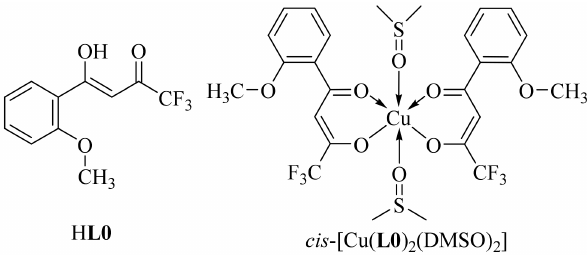
Figure 3. Structures of ligand H L0 and complex cis -[Cu( L0 ) 2 (DMSO) 2 ] [40]. Of 31 cancer incidences in women, the fourth most frequent type is cervical carci- noma [46]. Hence, the human cervical epithelioid carcinoma cell line was chosen as a tumorigenic. The african green monkey kidney cell line was used as the normal (non- cancerous) line, since it is one of the most common mammalian continuous cell